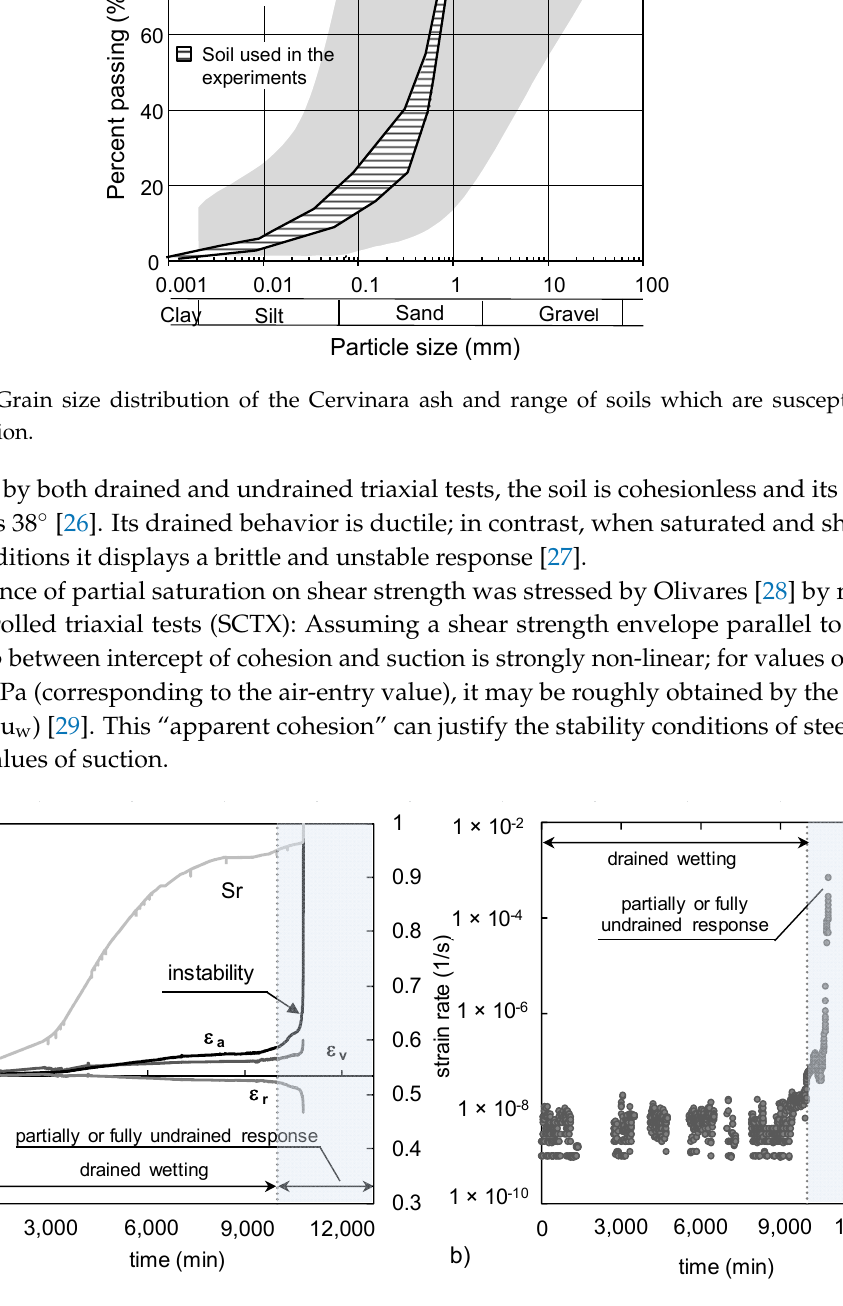
Table 1. Initial soil conditions and slope and rainfall characteristics. Test.